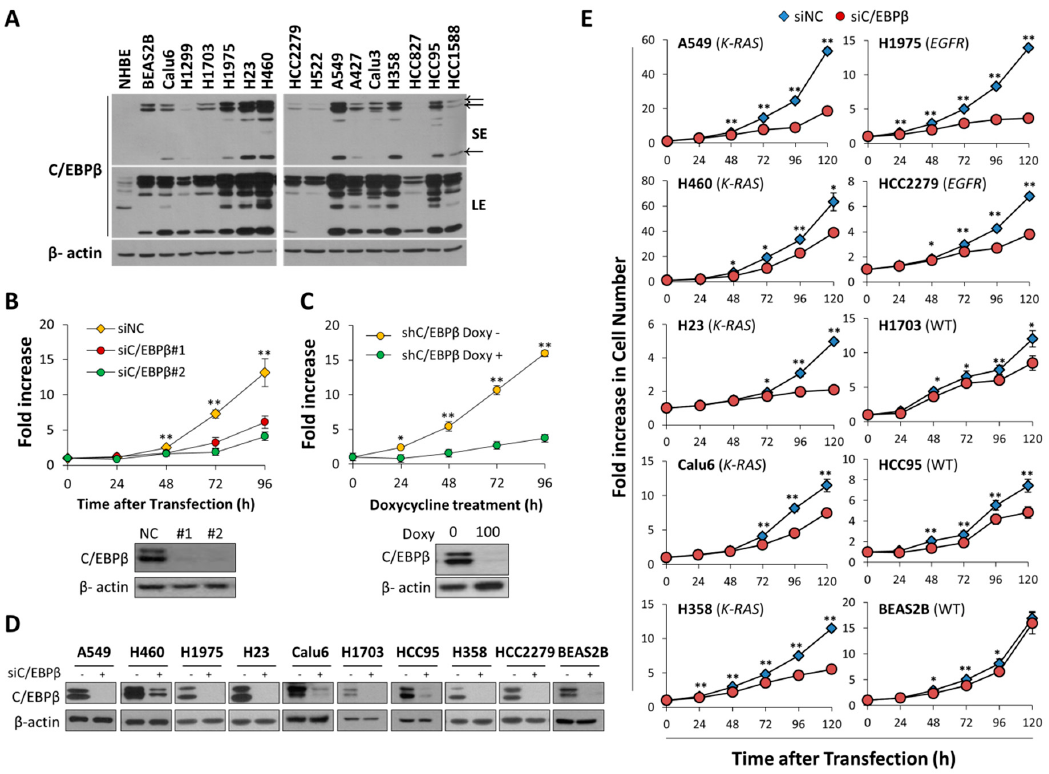
Figure 2. C/EBP β promotes cell proliferation in various subtypes of non-small cell lung cancer (NSCLC) cell lines. ( A ) C/EBP β protein levels in normal human bronchial epithelial cells (NHBE), immortalized human